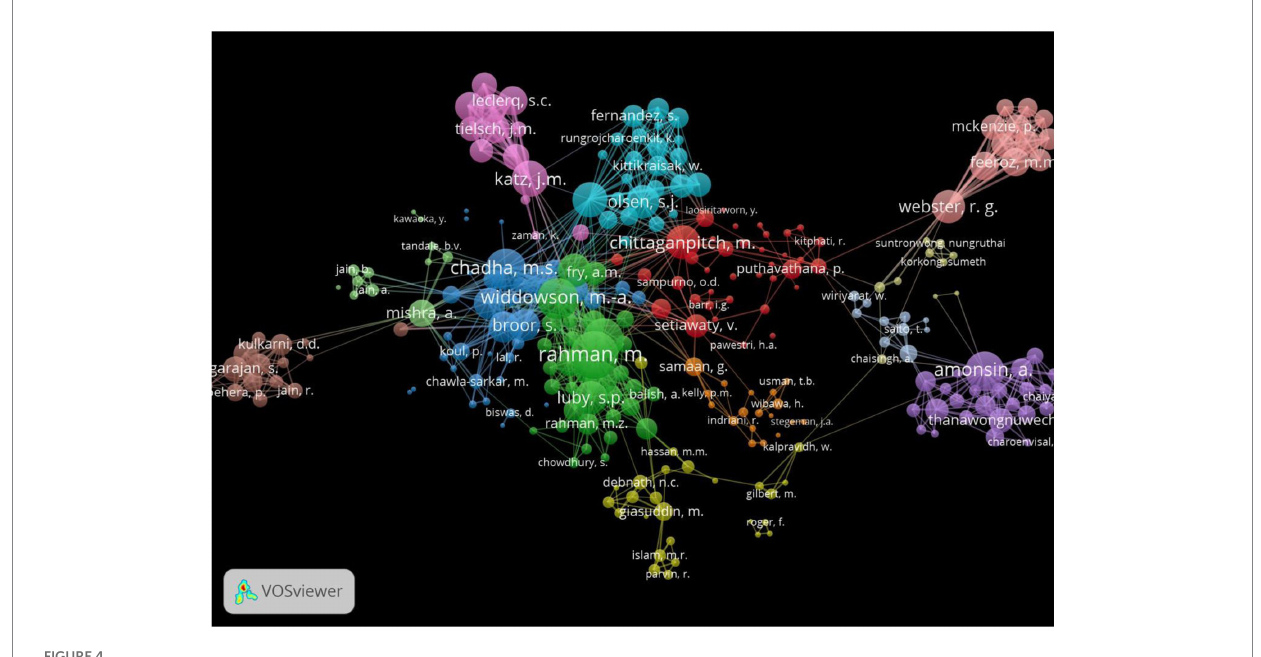
FIGURE 4 Network visualization of connectivity of authors